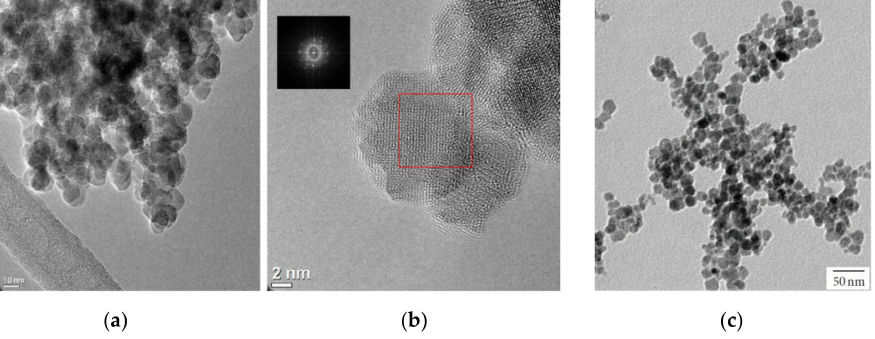
Figure 9. TEM: γ -Fe 2 O 3 nanoparticles, ( a , b ), ( c ). Obtained permission from Ref. [67]. Copyright 2015 Elsevier, Obtained permission from Ref. [68]. Copyright 2014 Hindawi Publishing